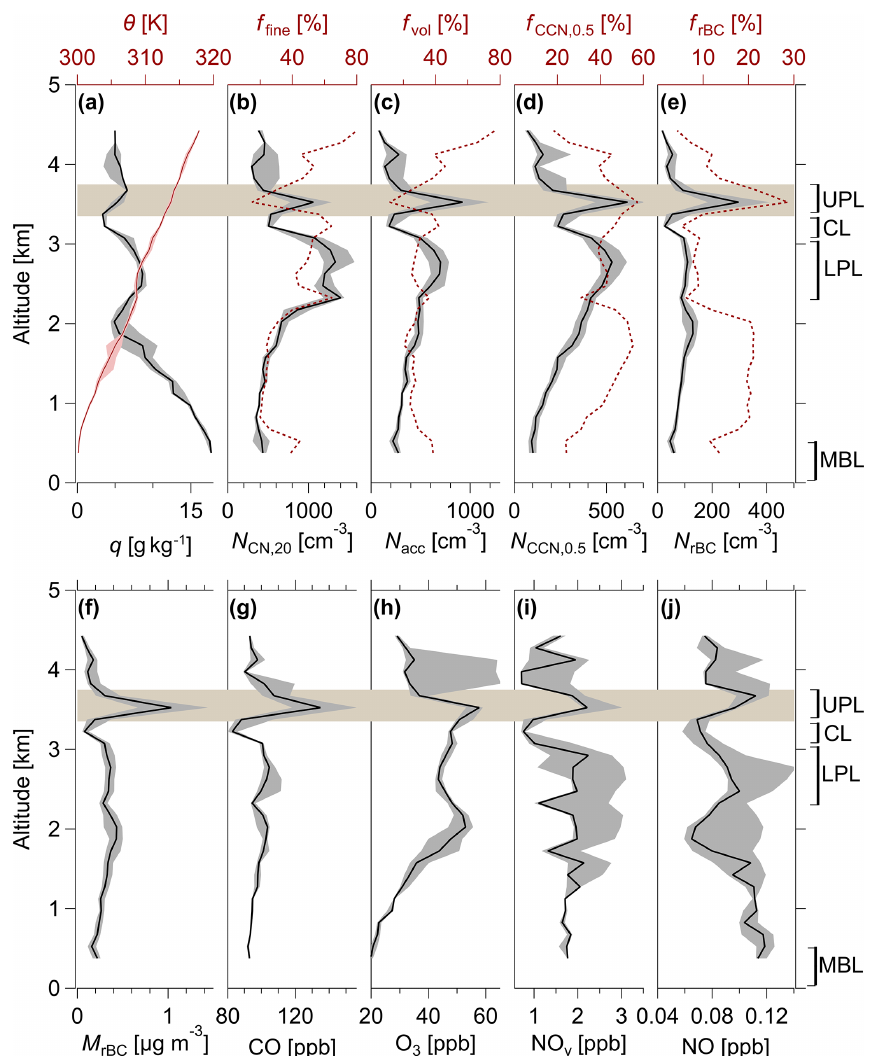
Figure 3. Vertical profiles of selected meteorological, aerosol, and trace gas parameters measured off the Brazilian coast during flight AC19: (a) potential temperature, θ , and water vapor mass mixing ratio, q ; (b) total aerosol particle number concentration, N CN , 20 , and ultrafine particle number fraction, f fine ; (c) accumulation-mode particle number concentration, N acc , and volatile particle number fraction, f vol ; (d) CCN number concentration at S = 0 . 5%, N CCN , 0 . 5 , and activated fraction at S = 0 . 5%, f CCN , 0 . 5 ; (e) rBC number concentration, N rBC , and rBC number fraction, f rBC ,N ; and (f) rBC mass concentration, M rBC ; (g) carbon monoxide, c CO ; (h) ozone, c O nitrogen, c NO ; and (j) nitrogen monoxide, c NO , mole fractions measured off the Brazilian coast during flight AC19. The black lines and y shadings represent the median and inter-quartile range calculated for 150m altitude bins during the flight section off the Brazilian coast (16:50 to 19:07UTC, blue line in Fig. 1). The brown shaded area represents the approximate vertical location of the upper pollution layer (UPL). The altitudes of the lower pollution layer (LPL), the clean layer (CL), and the marine boundary layer (MBL) are indicated on the right-hand side of the plot. The precise time windows when the UPL, CL, LPL, and MBL were probed are shown in Table S1 of the